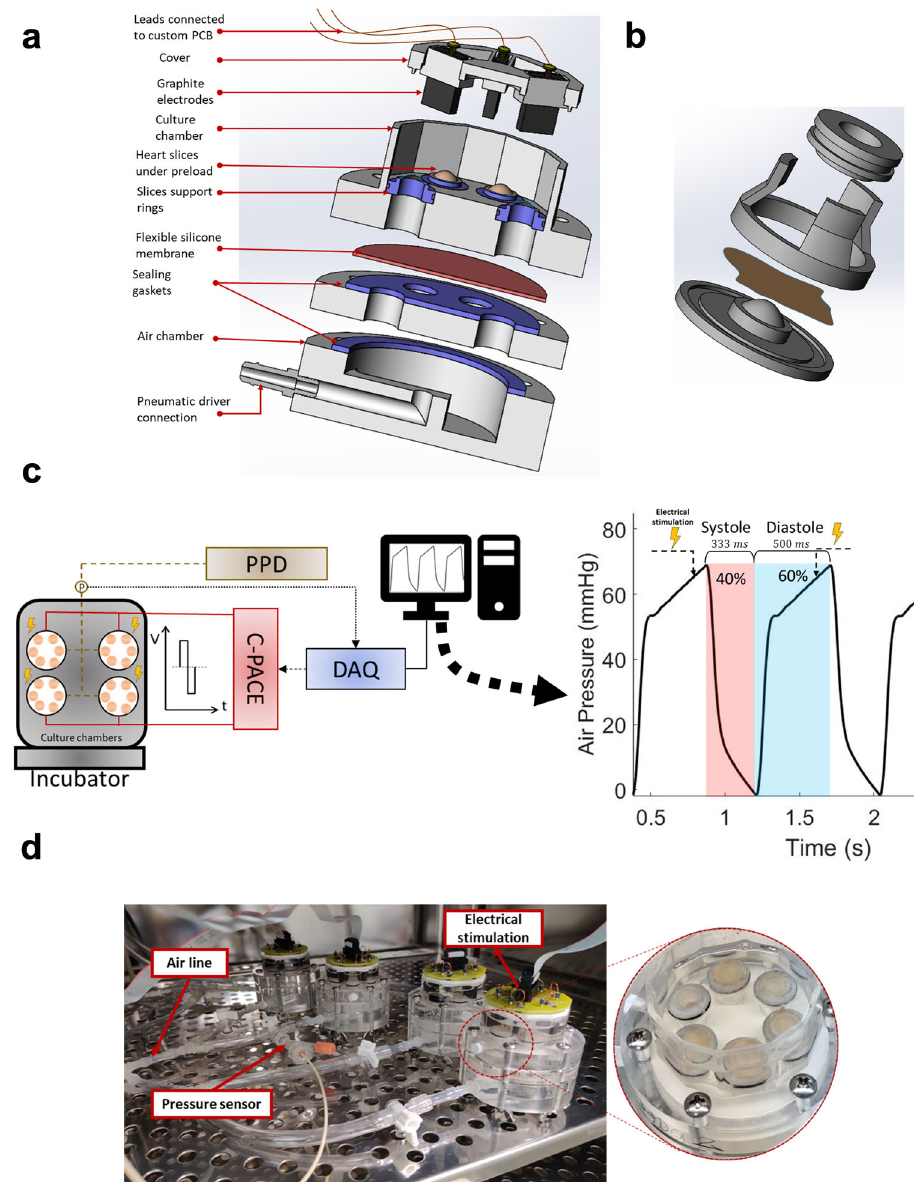
Fig. 1 Illustration of the cardiac tissue culture model (CTCM). a The tissue slices are attached to 7-mm diameter support rings shown in blue within the culture chamber of the device. The culture chamber was separated from the air chamber by a thin, fl exible silicone membrane. Between each chamber, a sealing gasket was placed to prevent leaks. The cover for the device contains graphite electrodes that provide electrical stimulation. b Schematic illustration of tissue oversizing apparatus, ring guide, and support ring. Tissue slices (brown) are positioned on the oversizing device, and the ring guide is placed in the grove on the outer edge of the apparatus. Using the guide, the support ring coated with histoacryl glue is carefully placed on the heart tissue slice. c A diagram depicting the timing of the electrical stimulation in relation to the pressure within the air chamber controlled by the programmable pneumatic driver (PPD). A data acquisition device was used to synchronize electrical stimulation using a pressure probe sensor. When the pressure within the culture chamber reaches a speci fi ed threshold, an impulse signal is sent to the C-PACE-EM device to induce electrical stimulation. d Image of four CTCM devices set up on a shelf of an incubator. These four devices are connected to a single PPD by airlines, and a pressure sensor is inserted into a hemostatic valve to monitor the pressure within the airline. Each device can accommodate six tissue